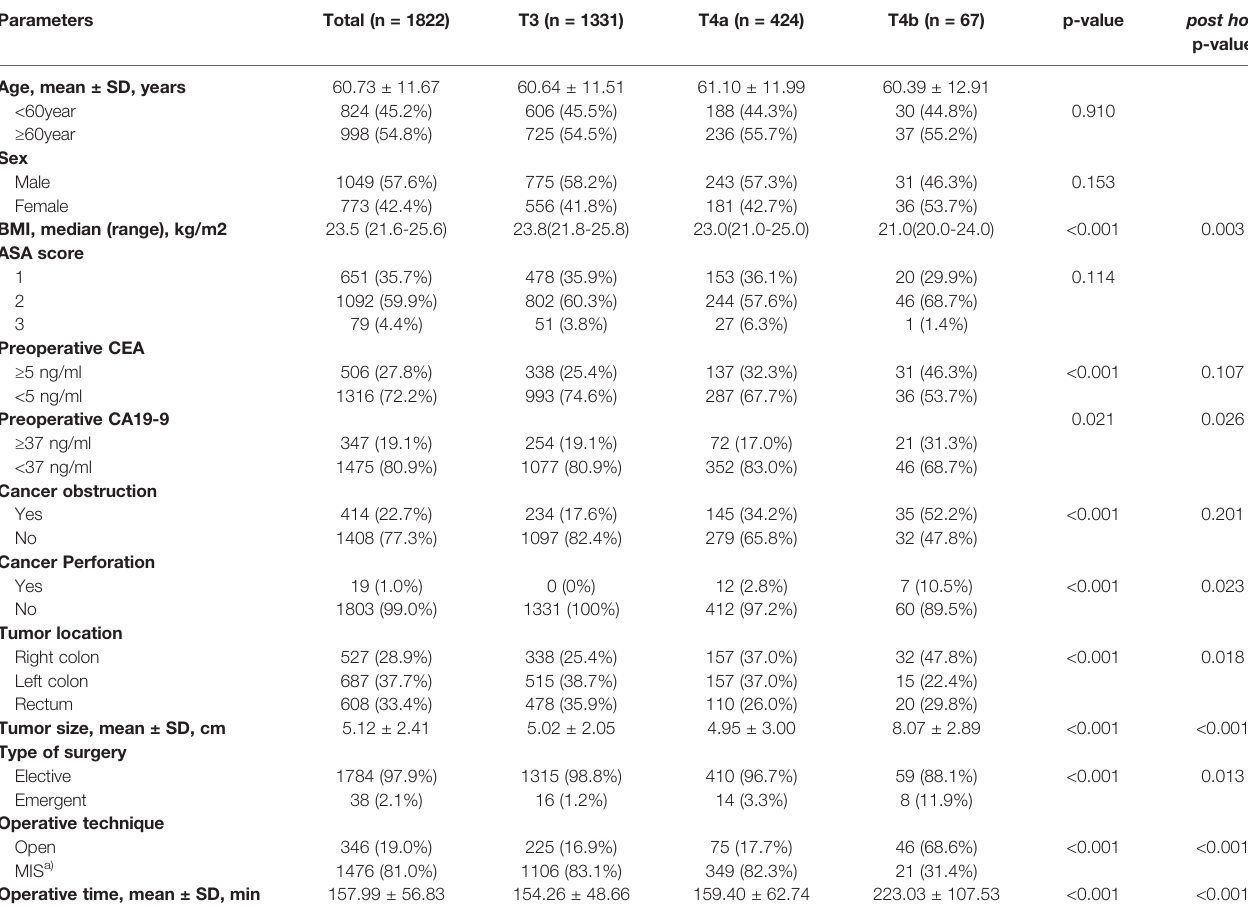
TABLE 1 | Baseline characteristics of the study subjects.